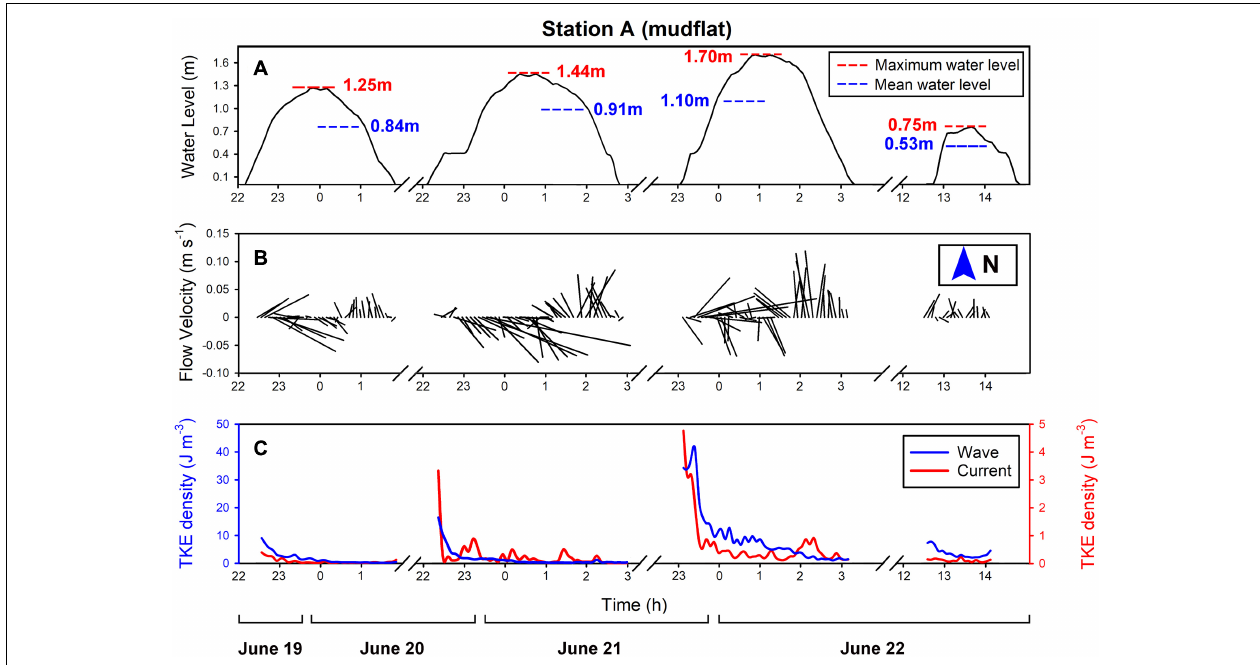
FIGURE 5 | Four tidal cycles were recorded at Station A (mudflat) from June 19 to 22: (A) water level variations in each tidal cycle, the maximum water level and the average water level are given separately; (B) flow velocity variations of each tidal cycle (the length of the flow vector segment represents the flow magnitude); (C) the TKE density variations of waves and currents in each tide